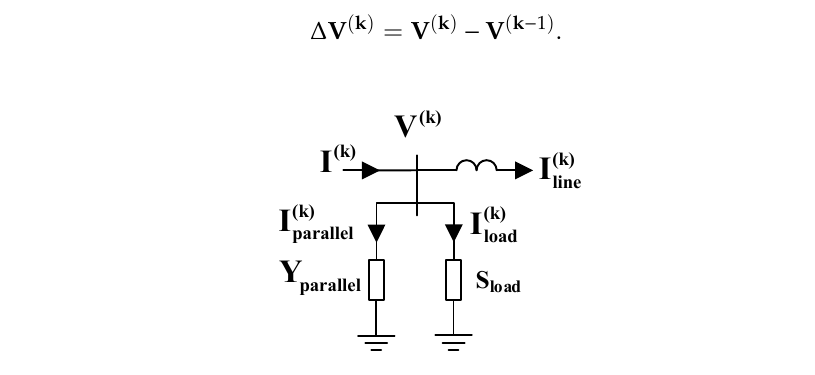
Figure 2. Currents that flow in a bus.